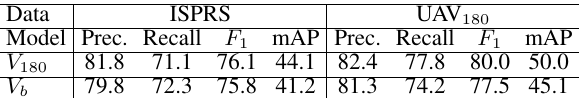
Table 2. Precision (Prec.), Recall, F 1 score and mAP for the binary masks predicted on the two test datasets by the variant V 180 of our method and the baseline V b .